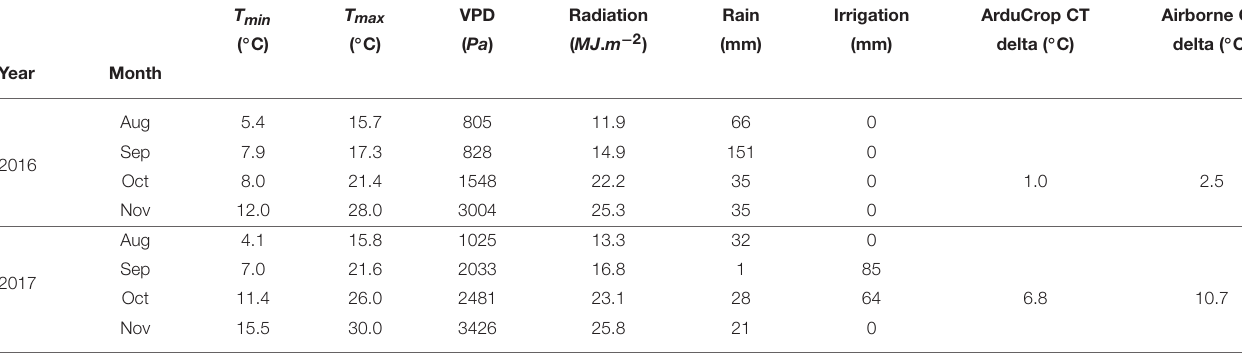
TABLE 1 | Experimental conditions during the canopy temperature (CT) measurement period for 2016 and 2017 at Yanco, New South Wales. T min T max VPD Radiation Rain Irrigation ArduCrop CT Airborne CT